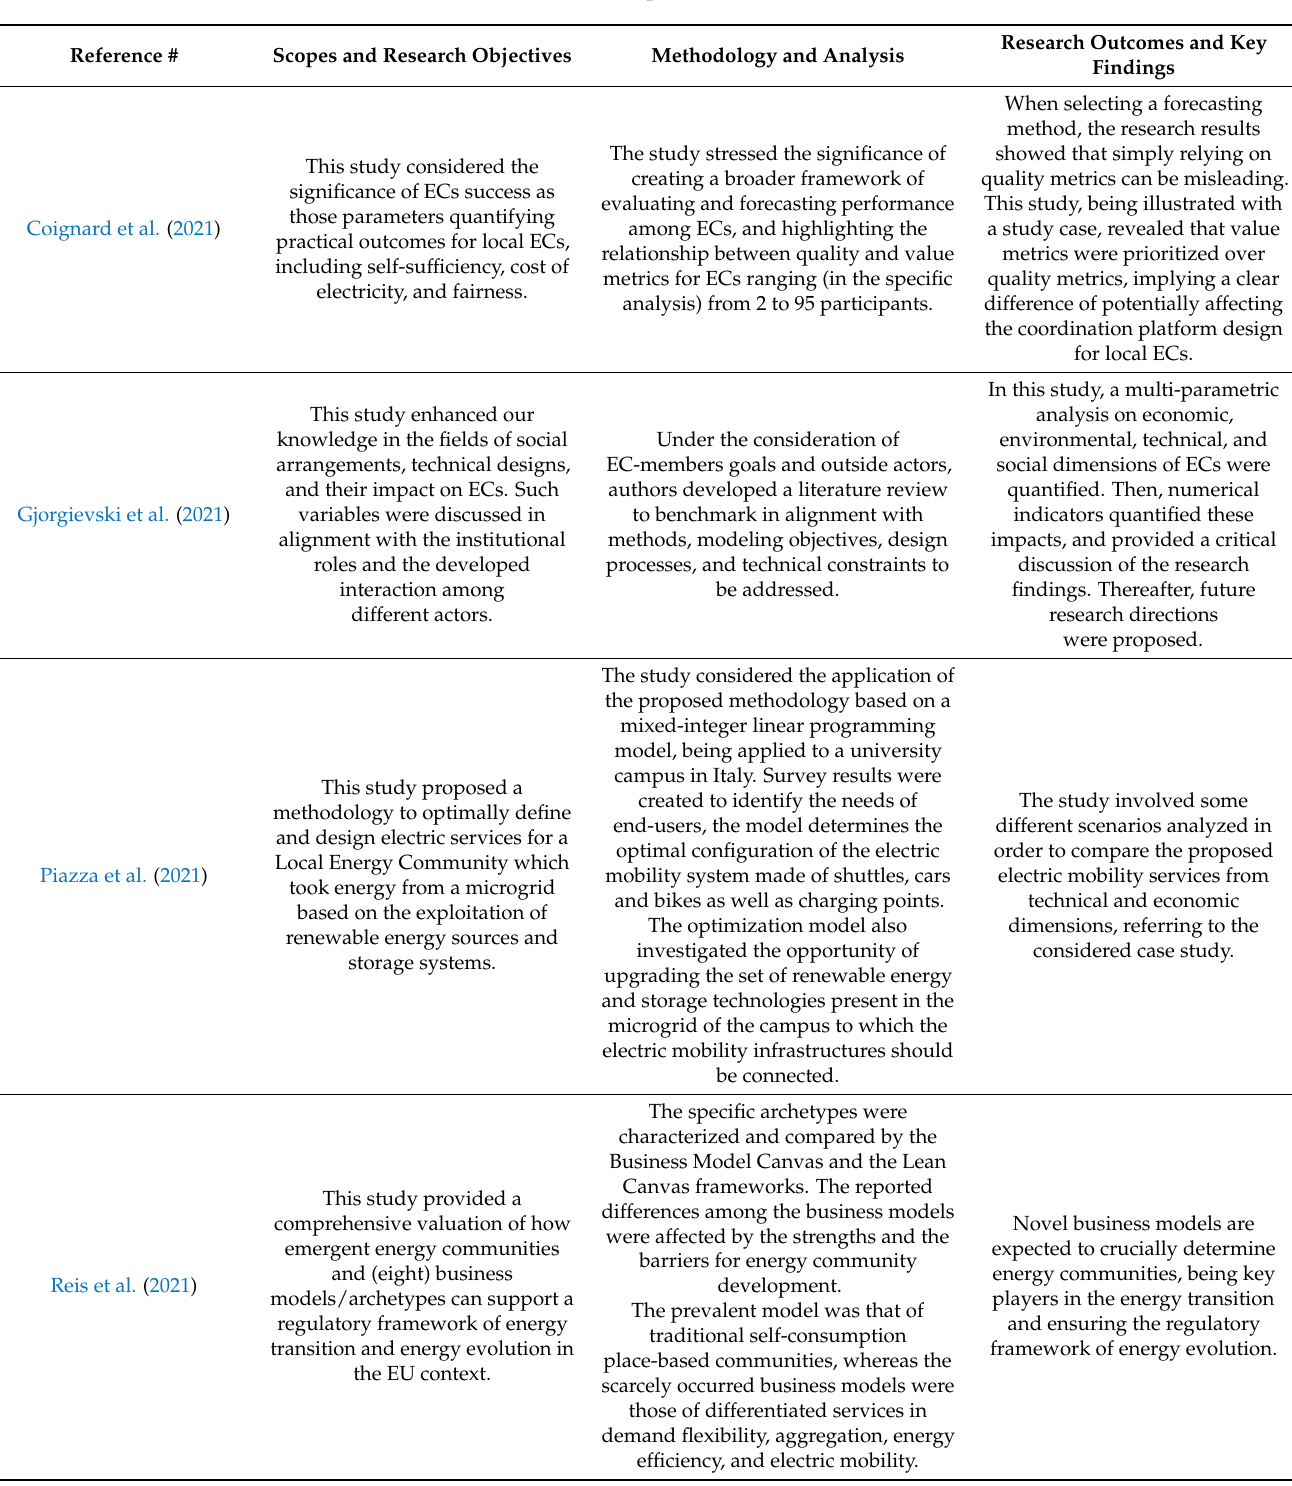
Table 7. The context of local energy—Group 2 (studies are presented in reverse chronological order and in last name of first author alphabetical